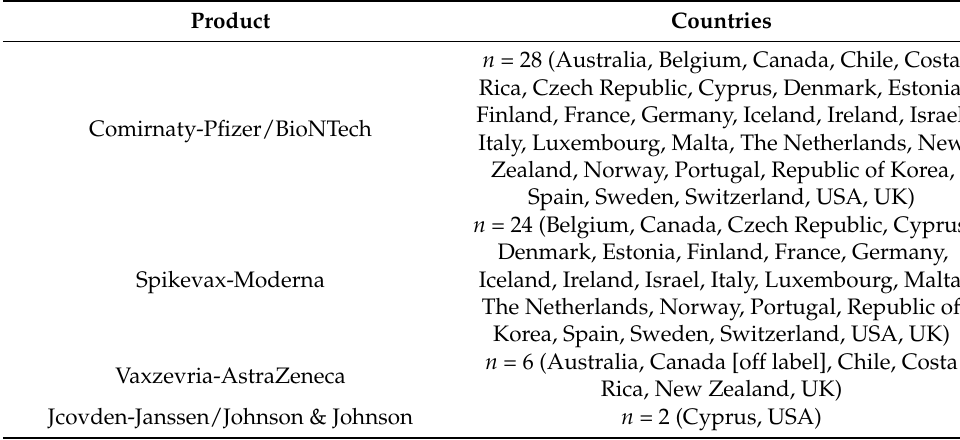
Table 2. Product used for the booster dose campaign against COVID-19 (countries might have used more than one